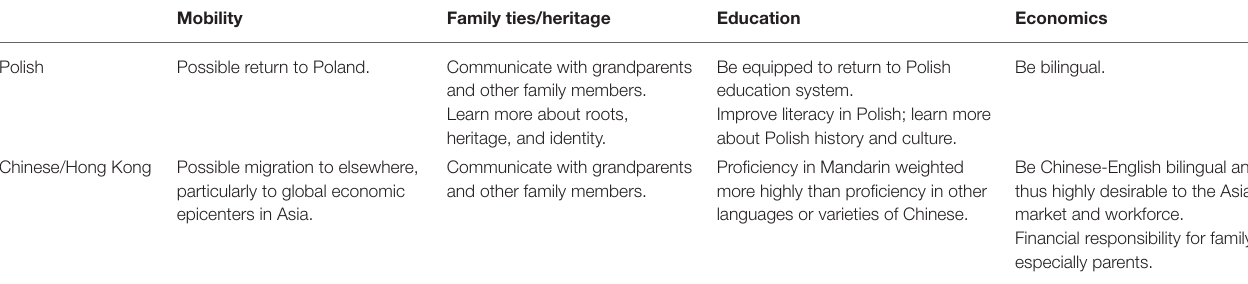
TABLE 1 | Summary of motivations for heritage language maintenance and